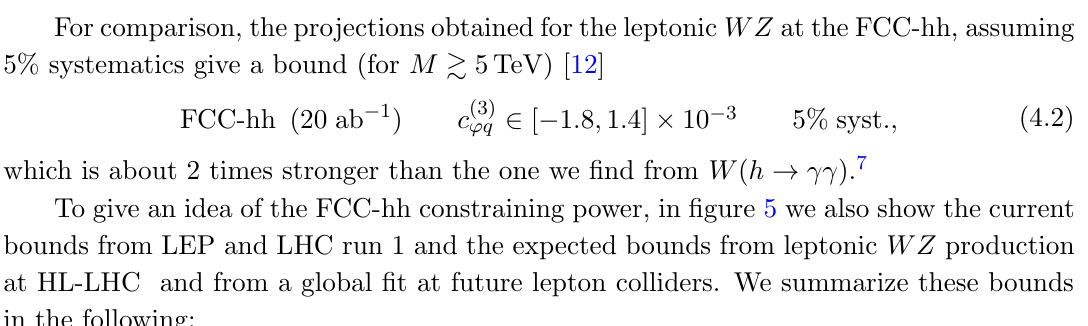
Figure 5 . Expected bounds on c (3) ’q , setting (cid:3) = 1 TeV, at the FCC-hh with 30 ab of the maximal invariant mass cut M . The bounds correspond to (cid:1) (cid:31) 2 = 3 : 84 ( ’ 95% C.L.) and are obtained from a single parameter (cid:12)t to the O (3) ’q operator. The dashed, solid and dotted blue lines show the bounds for 1%, 5% and 10% systematics. The orange shaded area shows the expected bound from a global (cid:12)t at FCC-ee [21], while the shaded red area delimited by a solid (dashed) line corresponds to the HL-LHC with 3 ab (cid:0) 1 (LHC run 1) bounds from leptonically decaying WZ [12]. The light blue shaded are corresponds to the bound obtained by LEP [59]. The diagonal dashed and solid gray lines show the values of the Wilson coe(cid:14)cient expected in weakly- coupled ( c (3) ’q (cid:24) g 2 = (4 M 2 )) and strongly-coupled ( c (3) ’q (cid:24) (4 (cid:25) ) 2 = (4 M 2 )) new physics models